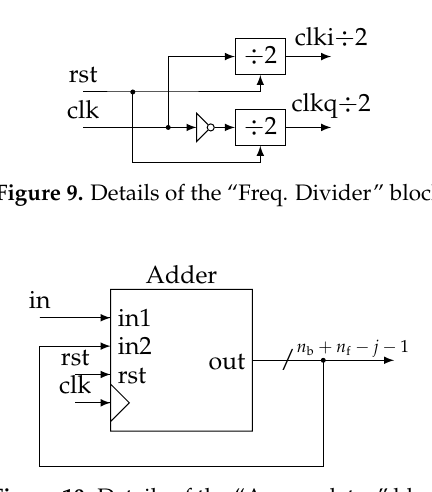
Figure 10. Details of the “Accumulator”